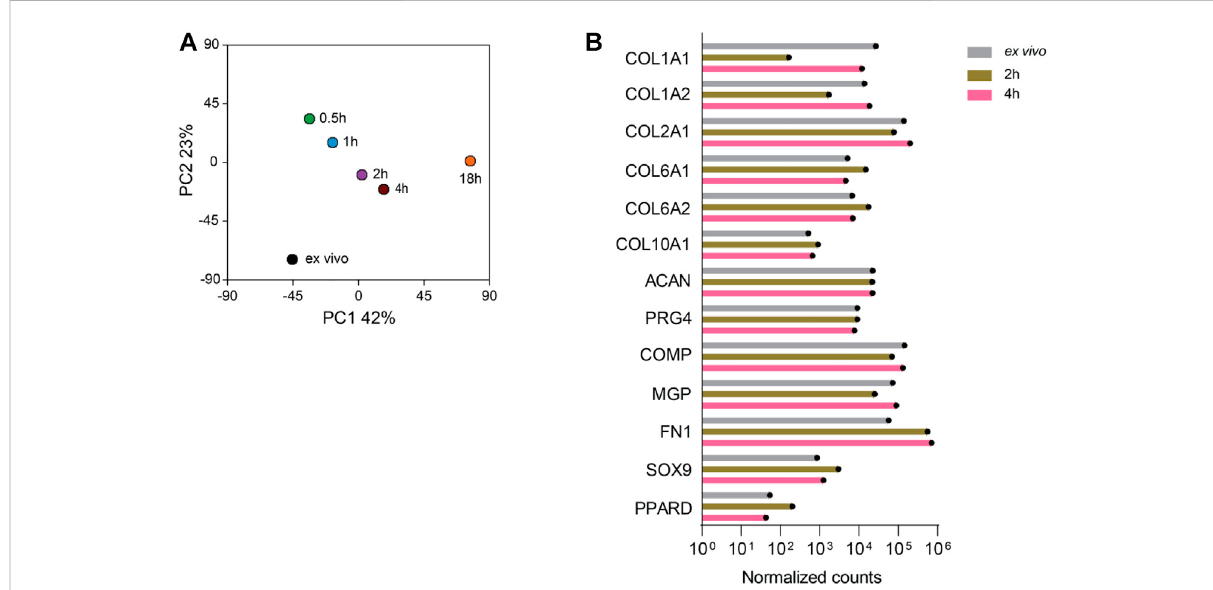
FIGURE 3 The RNA sequencing pro fi les of chondrocytes isolated from cartilage by digestion for 2 and 4 h are closest to the RNA-seq pro fi le of the chondrocytesobtaineddirectlyexvivo.RNA-seqanalysiswasperformedonchondrocytesharvestedafterdigestionofcartilagewith2%collagenase II for 0.5, 1, 2, or 4 h and 0.1% collagenase II for 18 h. In addition, RNA was isolated directly ex vivo from the cartilage tissue of the same patient and sequenced. (A) The gene expression PCA plot provides a map of the distances between the samples as a measure of the differences between theRNAtranscriptomesoftheisolatedcellsandthechondrocytesincartilagetissueexvivo. (B) Theexpressionof13hallmarkgenesofchondrocytes includingCOL1A1,COL1A2,COL2A1,COL6A1,COL6A2,COL10A1,ACAN,PRG4,COMP,MGP,FN1,SOX9,andPPARDintheexvivosampleandafter digestion for 2 and 4 h is plotted. Data were generated from the sample from one